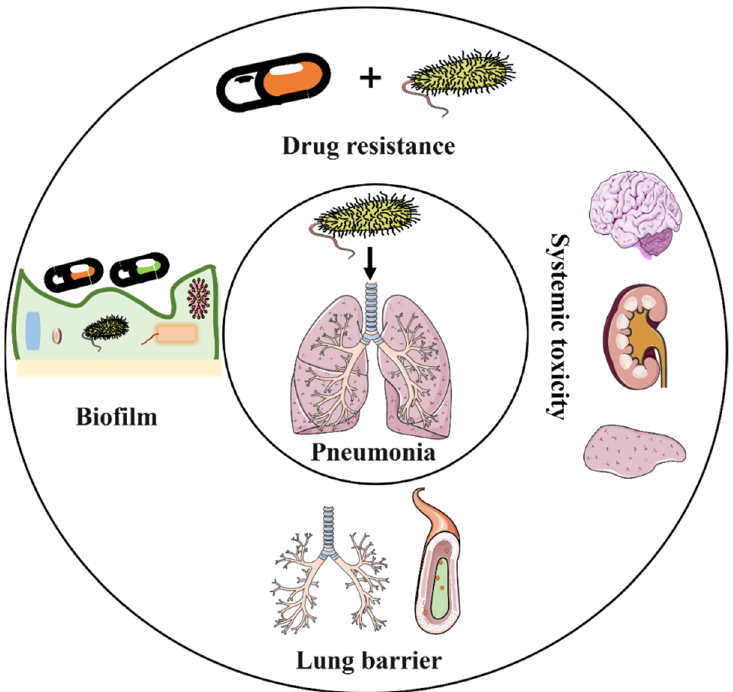
Figure 2. Challenges in the implementation of intravenous antibiotic agents in the antimicrobial treatment of pneumonia.